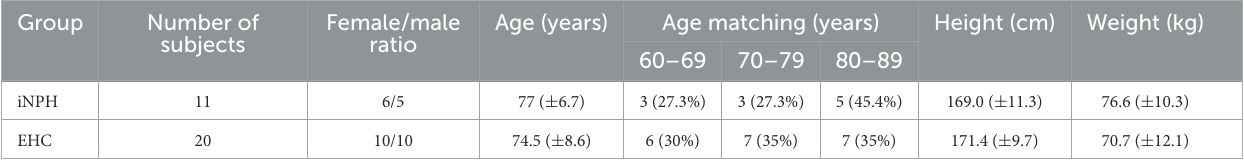
TABLE 1 Demographic and anthropometric data of patients suffering from idiopathic normal pressure hydrocephalus (iNPH) and of the elderly healthy control (EHC) group.